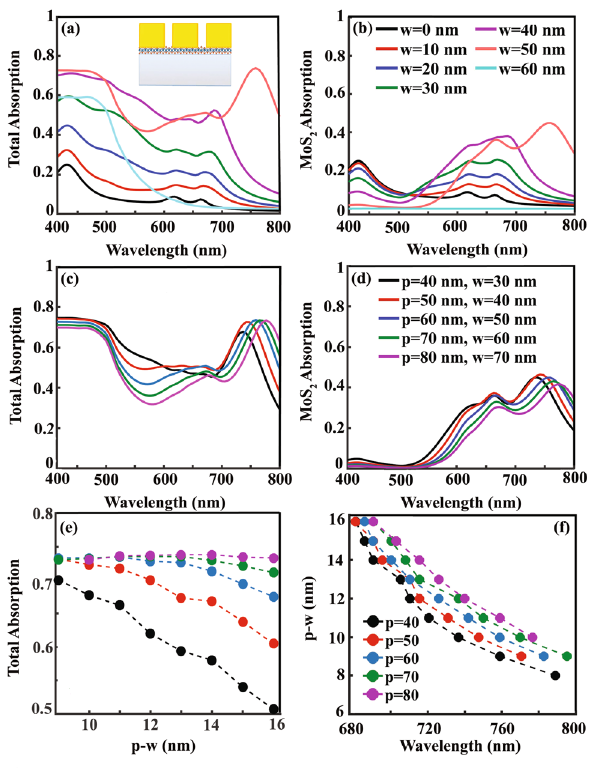
( w = 60 nm, cyan solid line) and no gold grating ( w = 0 , black solid line) are also included. (c) total and (d) MoS 2 absorption when grating pitch varies from p = 40 nm to p = 80 nm with w of the gratings set